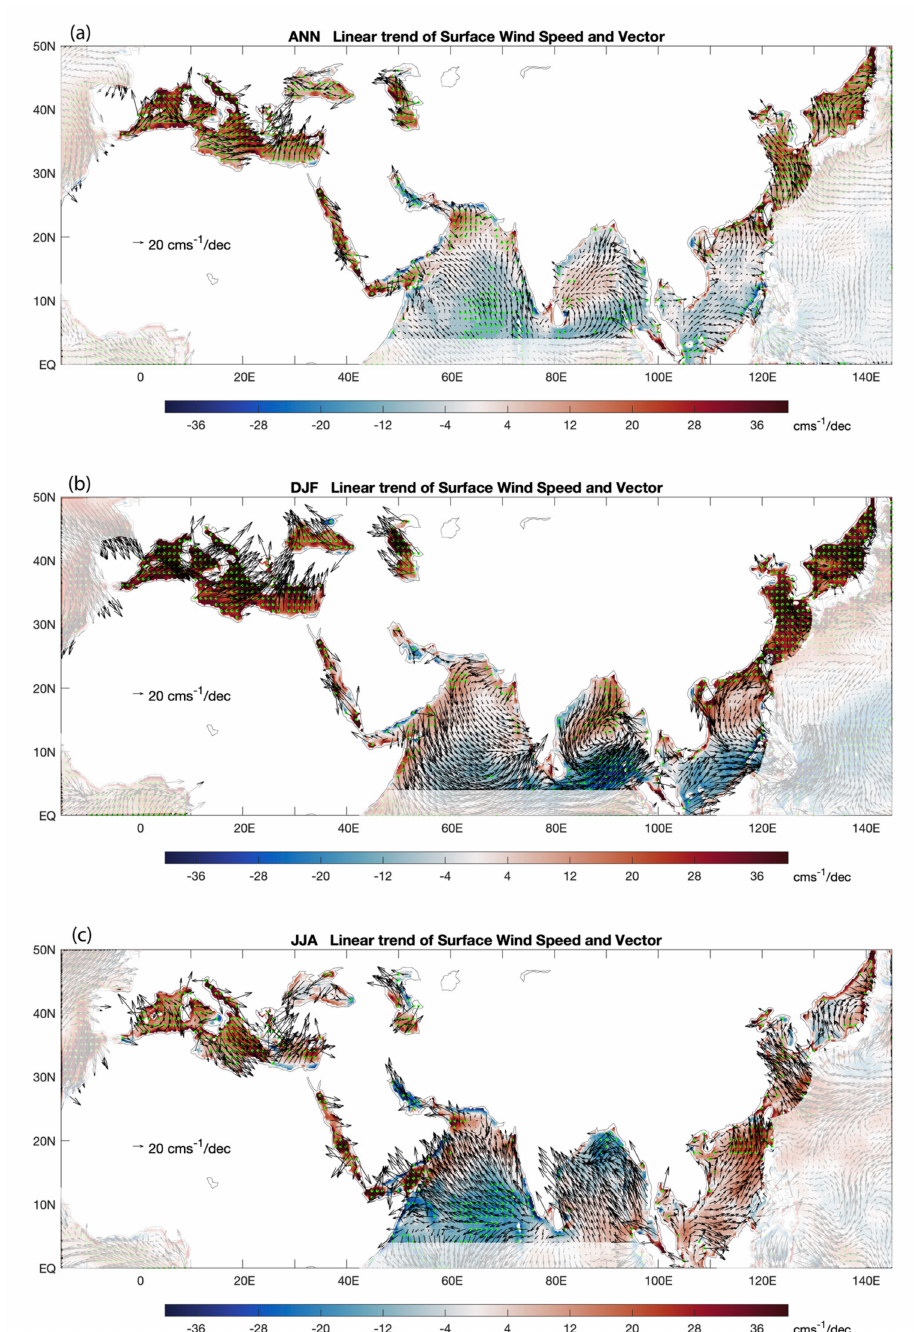
Figure 8. Linear trends of surface wind speed and vector for ( a ) annual mean, ( b ) the winter season (December-January-February), ( c ) the summer season (June-July-August). The green dotted areas denote the linear trends of wind speed that are significant at the 90% confidence interval. The ocean regions outside of the marginal seas are